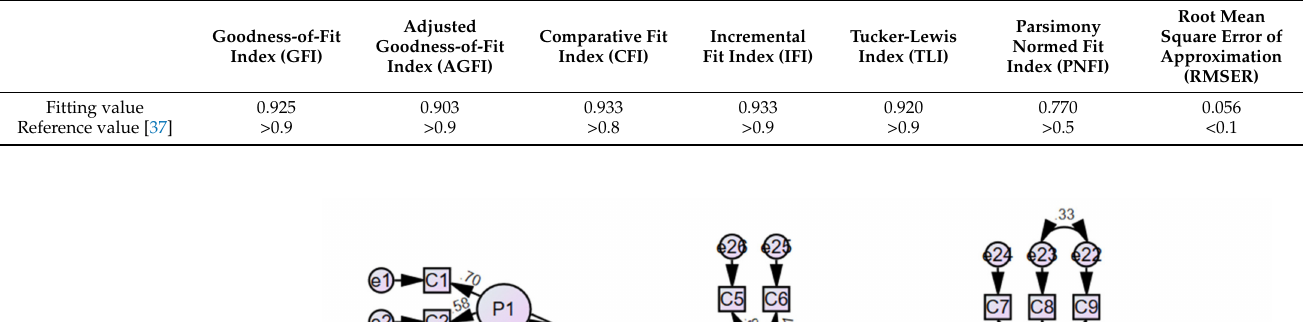
Table 5. Indices of model fitness for the structural equation model.